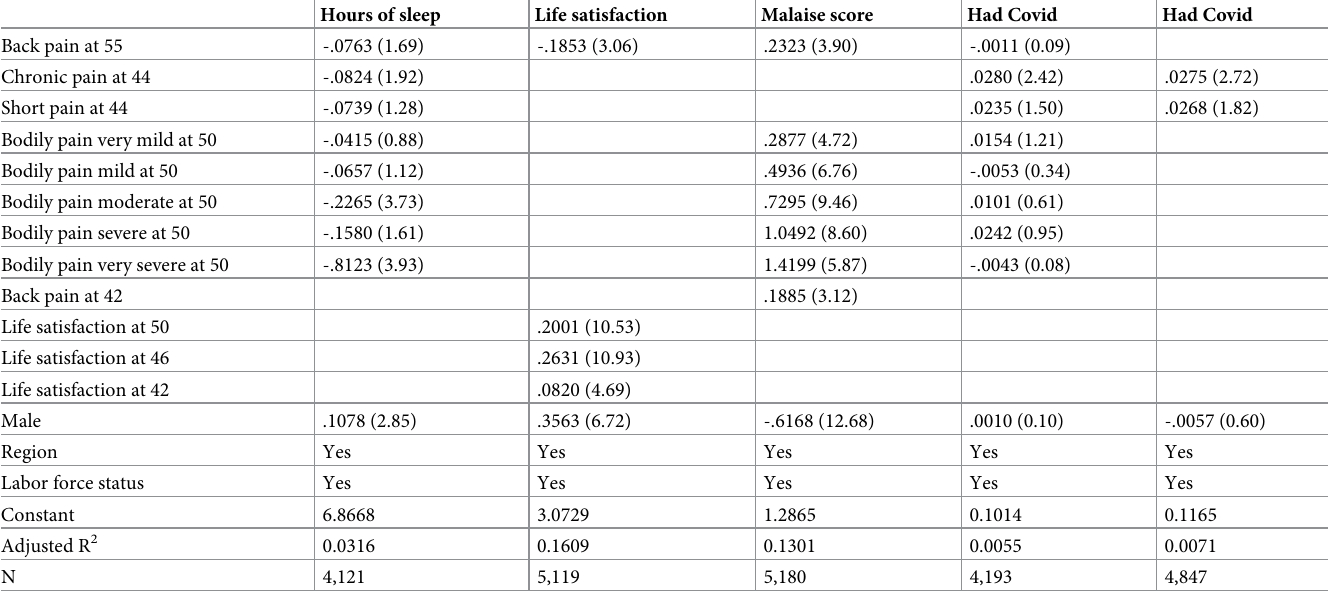
Table 17. Covid, health and well-being, covid sweep 3 survey at 62, February-March